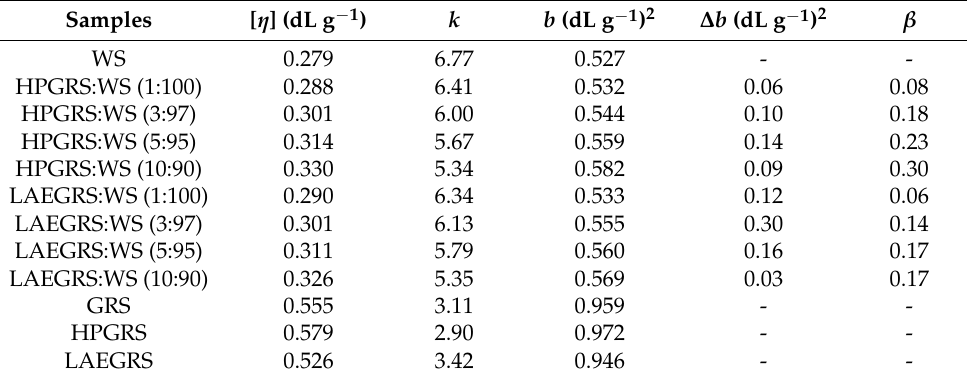
Table 1. The numerical values of polymer–polymer interaction coefficient and parameters for different proportions of HPGRS and LAEGRS (0%, 1%, 3%, 5%, and 10%) blended with WS respectively. Samples